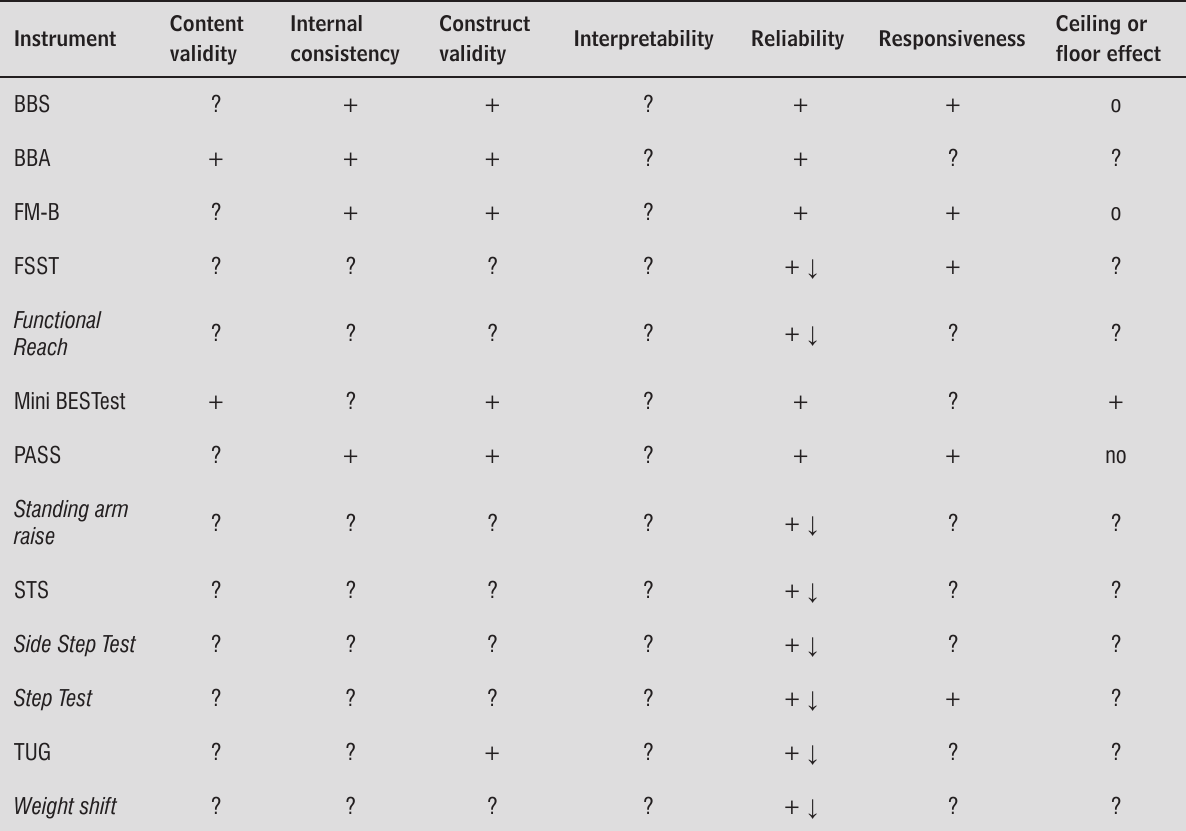
Table 1 - Psychometric properties of the instruments for clinical assessment of balance in hemiparesis Instrument